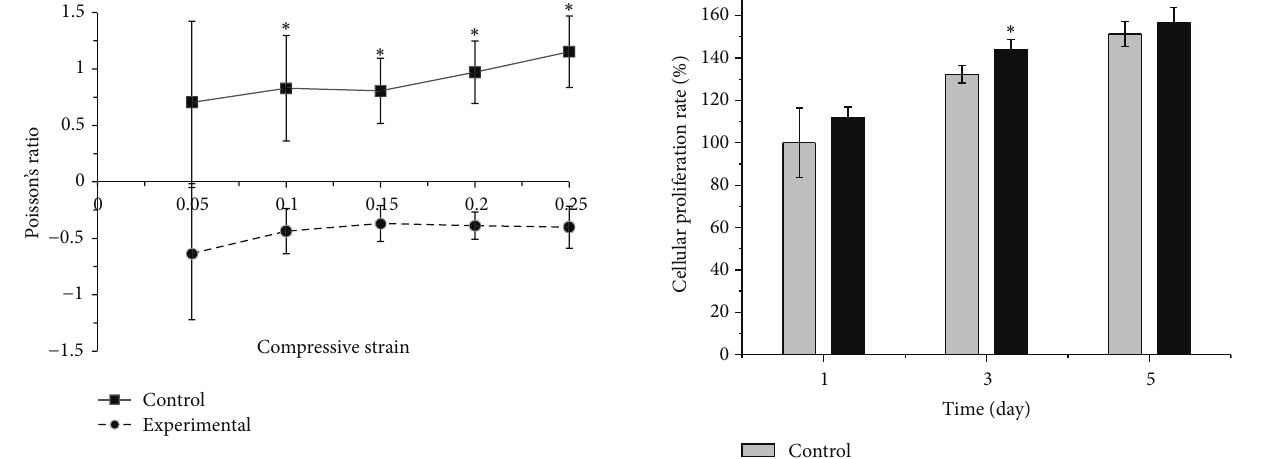
Figure 6: Poisson’s ratio variation of prepared polyurethane scaf- foldswithstrainrangeswithcompressiveloading( ∗ 𝑃 < 0.05 , 𝑛 = 5 ).